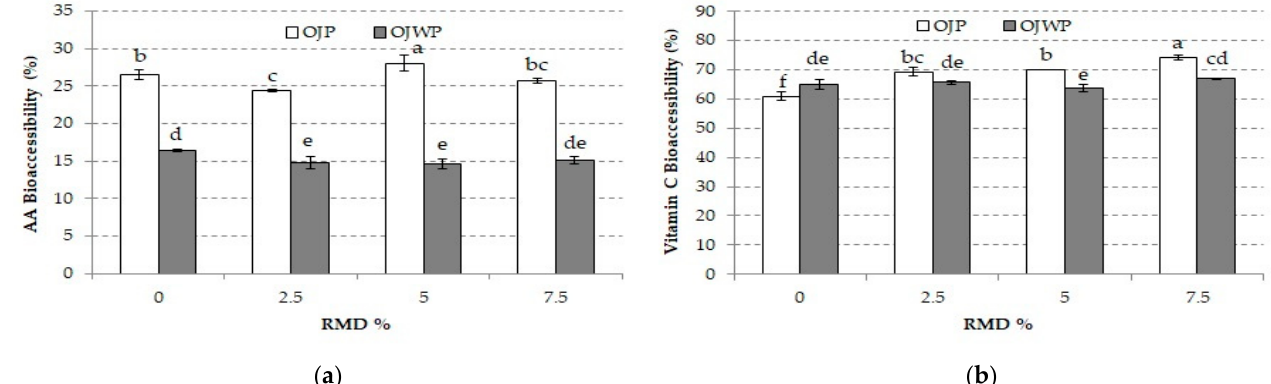
Figure 6. ( a ) Mean values and standard deviation of ascorbic acid (AA) bioaccessibility of pasteurized orange juice (OJP and OJWP) with 0, 2.5, 5, and 7.5 RMD%. ( b ) Mean values and standard deviation of vitamin C (VC) bioaccessibility of pasteurized orange juice (OJP and OJWP) with 0, 2.5, 5, and 7.5 RMD%. Letters indicate homogeneous groups established by the ANOVA ( p < 0.05) for each parameter analyzed. OJP, orange juice with pulp; OJWP, orange juice without pulp.